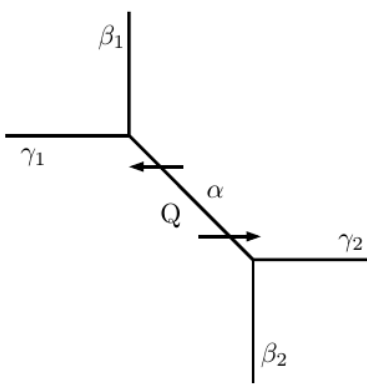
Figure 13: ( − 1, − 1 ) curve with the inner edge in the canonical